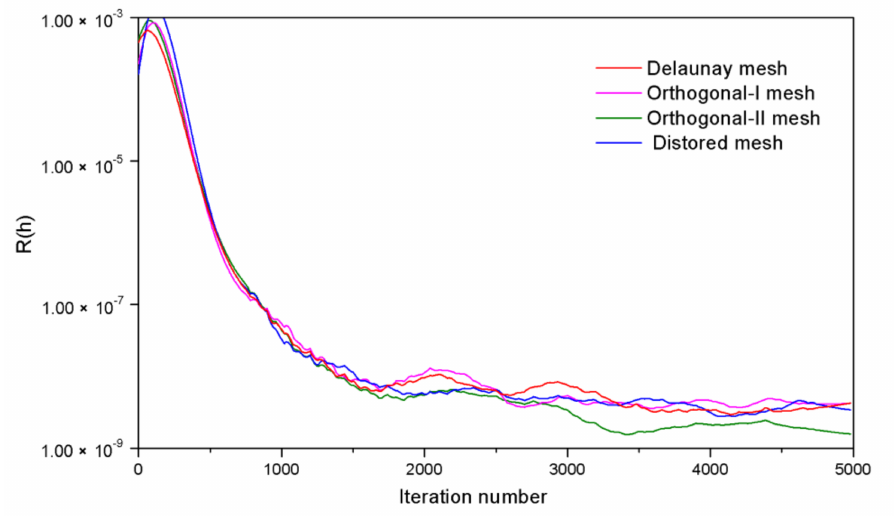
Figure 16. Global relative errors of water depth on different types of mesh.